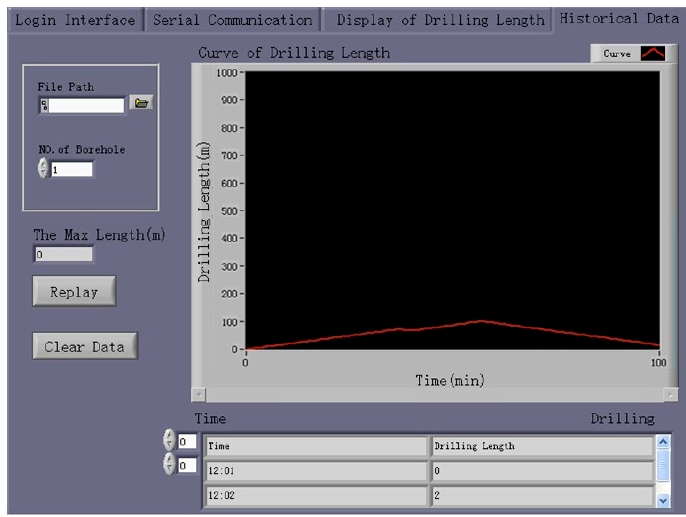
Figure 15. Replaying of the drilling-length results obtained using the visual drilling-length management